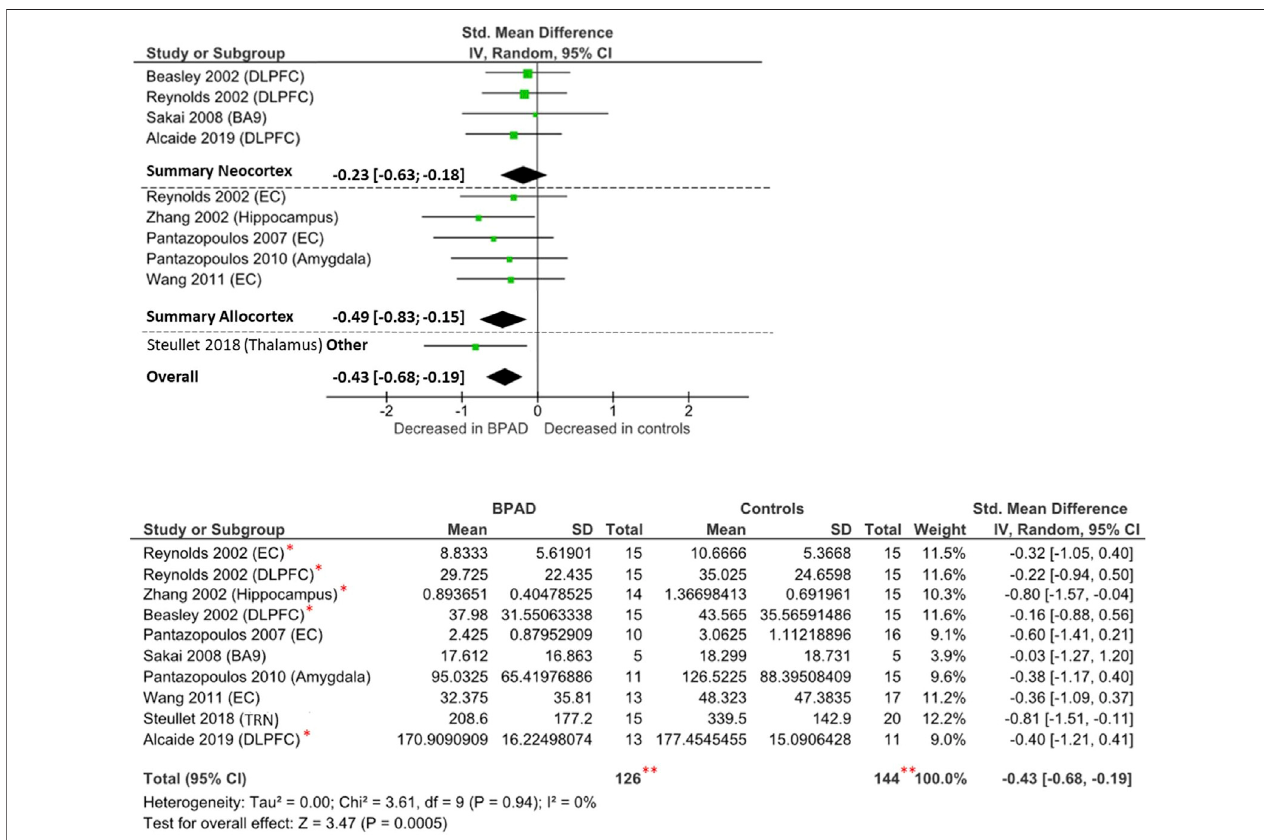
FIGURE 3 | Forest plot on PV-INs cell density: neocortical, allocortical, other, and overall comparison. ** The total number of participants displayed is twice the numberofsubjectsstudiedbyReynoldsetal.(2002),astheyperformedtheiranalysisinbothdorsolateralprefrontalcortexandentorhinalcortexandtherepetitionofthe samecohortofbrainsamples,whichhasbeenanalyzedbyseveralresearchgroups(Zhang2002;Beasley2002;Alcaide2019).*Thesestudiesanalyzed thesamebrain samples obtained from the Stanley Foundation Neuropathology Consortium brain collection (Torrey et al., 2000).